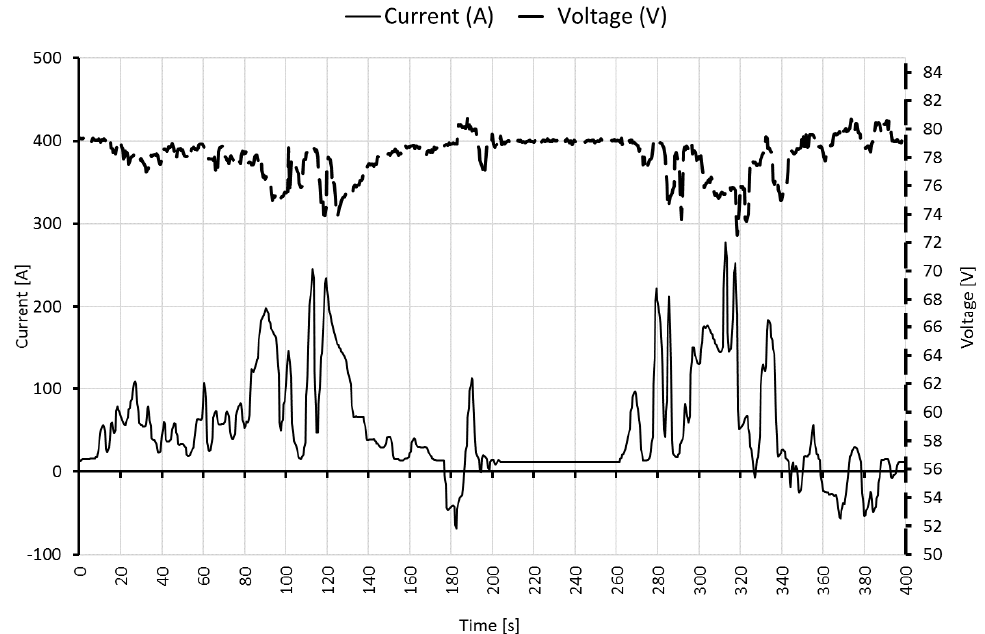
Figure 8. Voltage and current trends of P2.